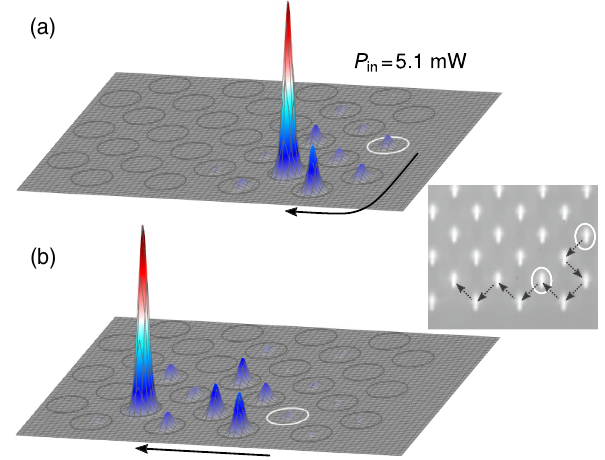
FIG. 4. Solitonlike edge states traveling unidirectionally around a corner. (a),(b) Experimentally measured output intensity pat- 5 . 1 mW associated with the IPR peak in Fig. 3(a). terns for P in ¼ Here, δ ¼ 0 . 26 ; the white circles indicate the lattice sites where the light is launched at the input. The inset shows the path of the most intense site. In both cases [i.e., (a) and (b)], the state propagates two lattice constants: the first around the corner, the second along the